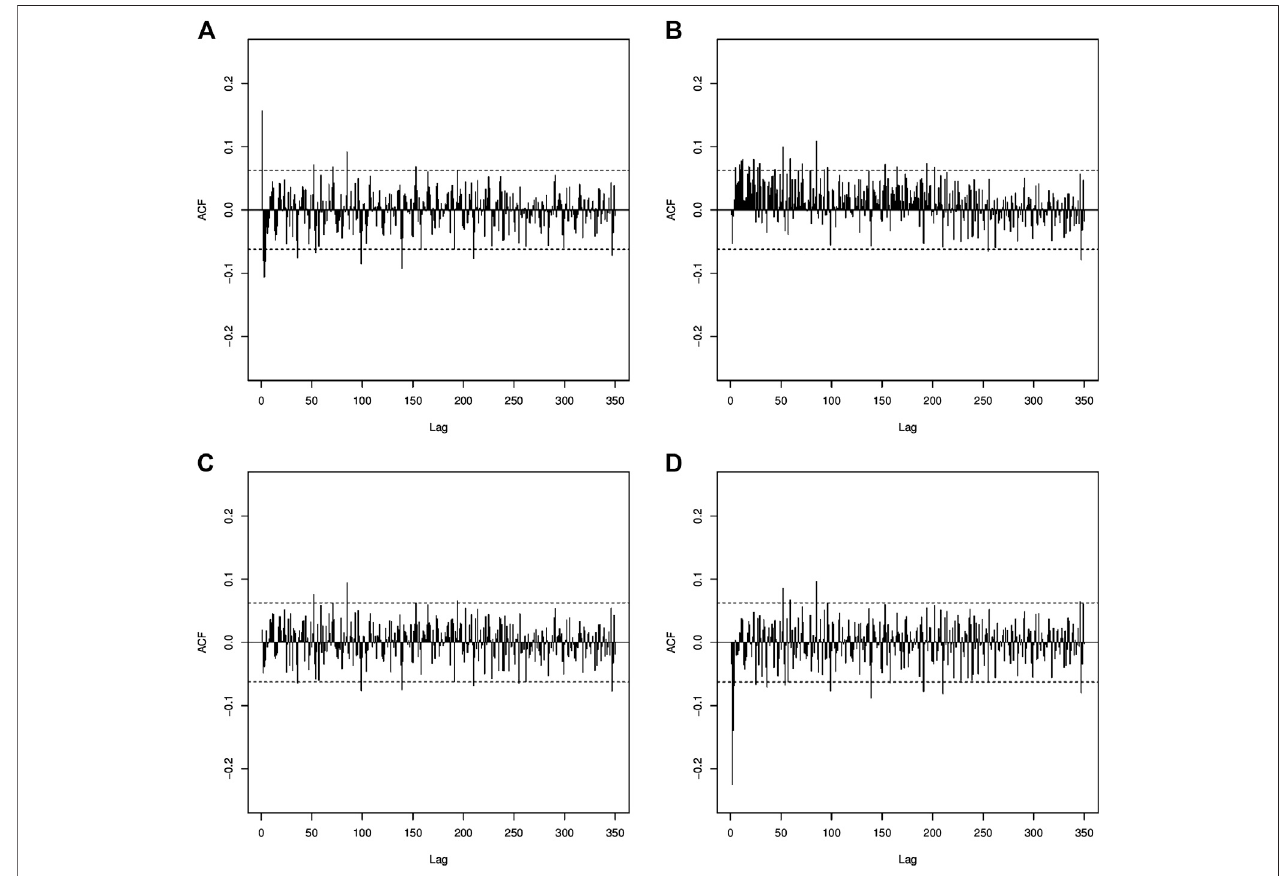
FIGURE4| Autocorrelation coef fi cients oftheresidualsoftheestimatedModels (A – D) aslabeledin Table1 .Thehorizontallinesindicate thecon fi denceintervalat 95% for not signi fi cant correlation coef fi cient.